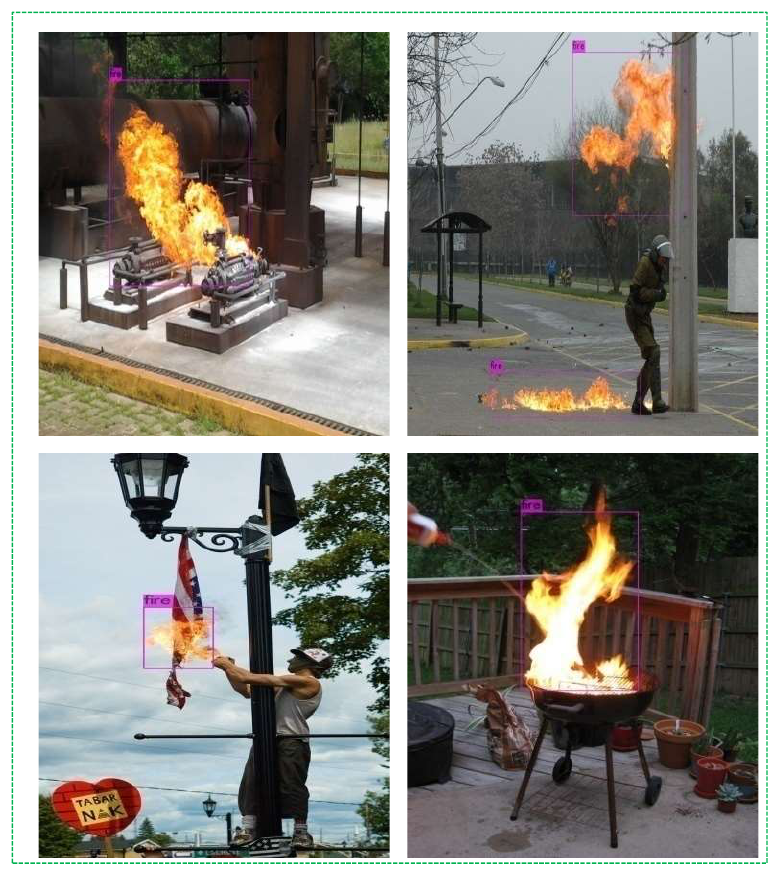
Figure 13. Visible experiments in different